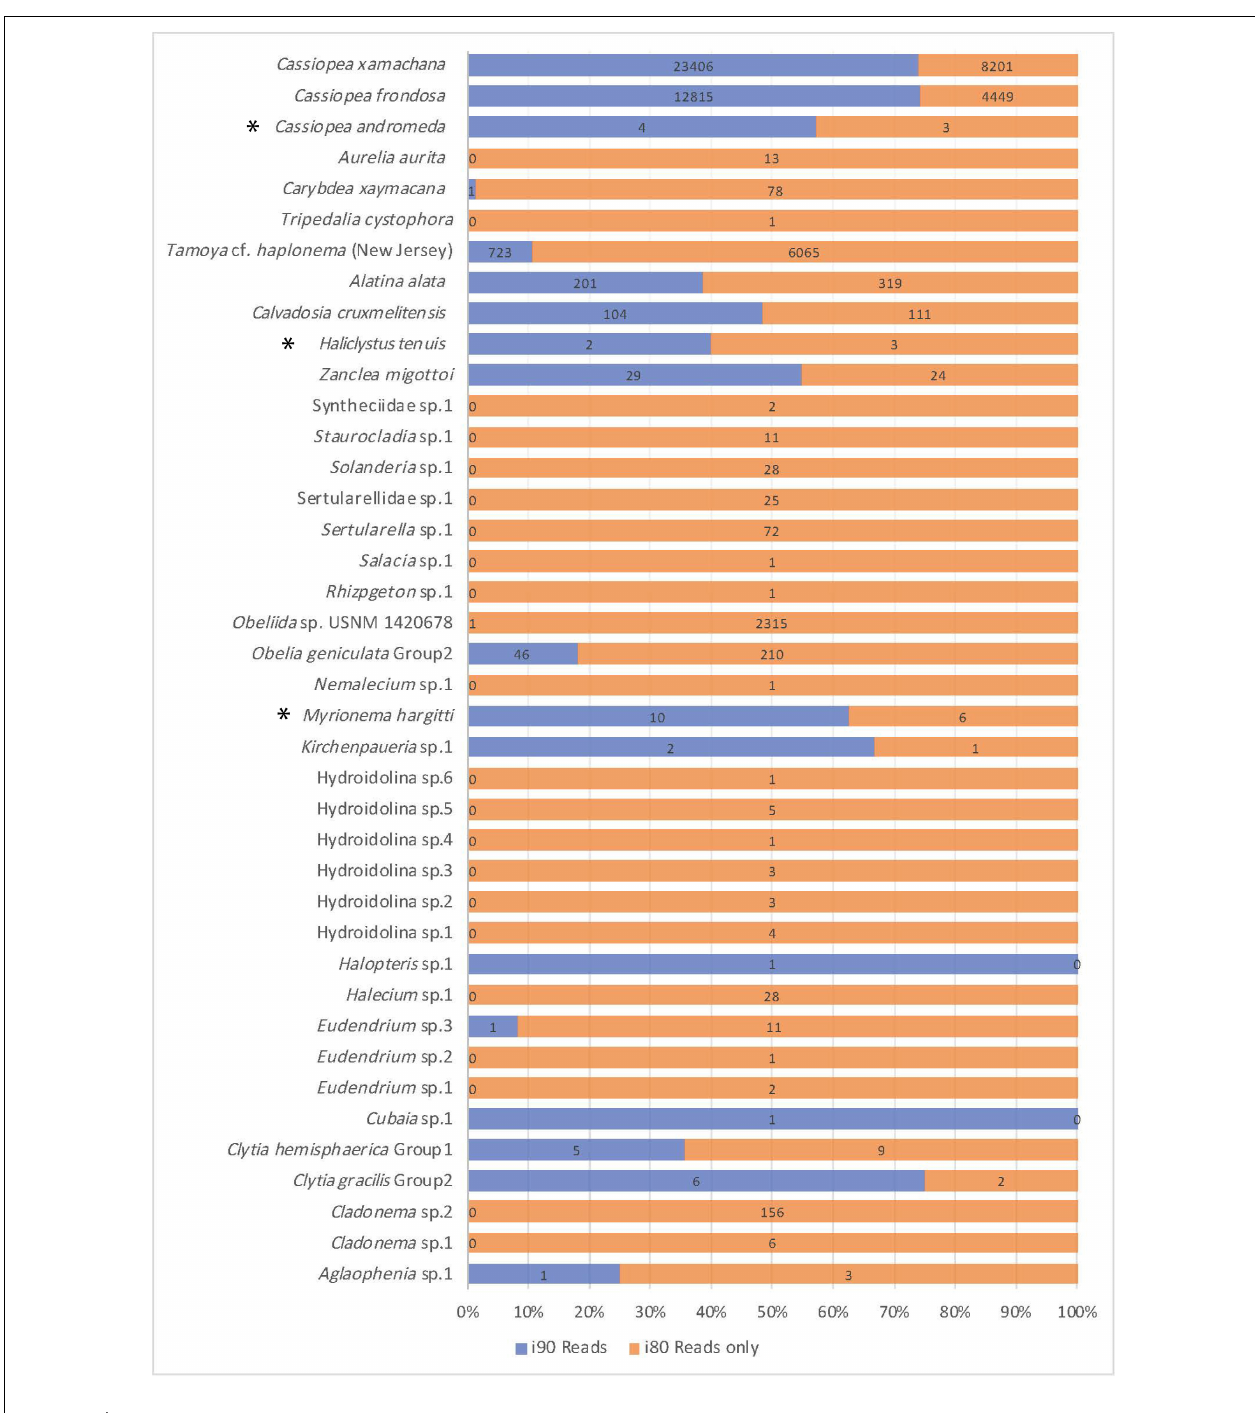
FIGURE 4 | Comparison of read number for jellyfish taxa recovered. Jellyfish taxa comprising 40 OTUs (putative species) identified at 80 and 90% identity cutoffs with BLASTN, recovered from medusozoan 16S rRNA gene eDNA metabarcoding data (shown are matches comprising three or more sequences). Taxonomic identity was determined against the GenBank sequence database (NCBI). Values reflect proportions prior to rarefaction analysis (subsample normalization), which resulted in loss of three minimally represented taxa ( ∗ ) across all